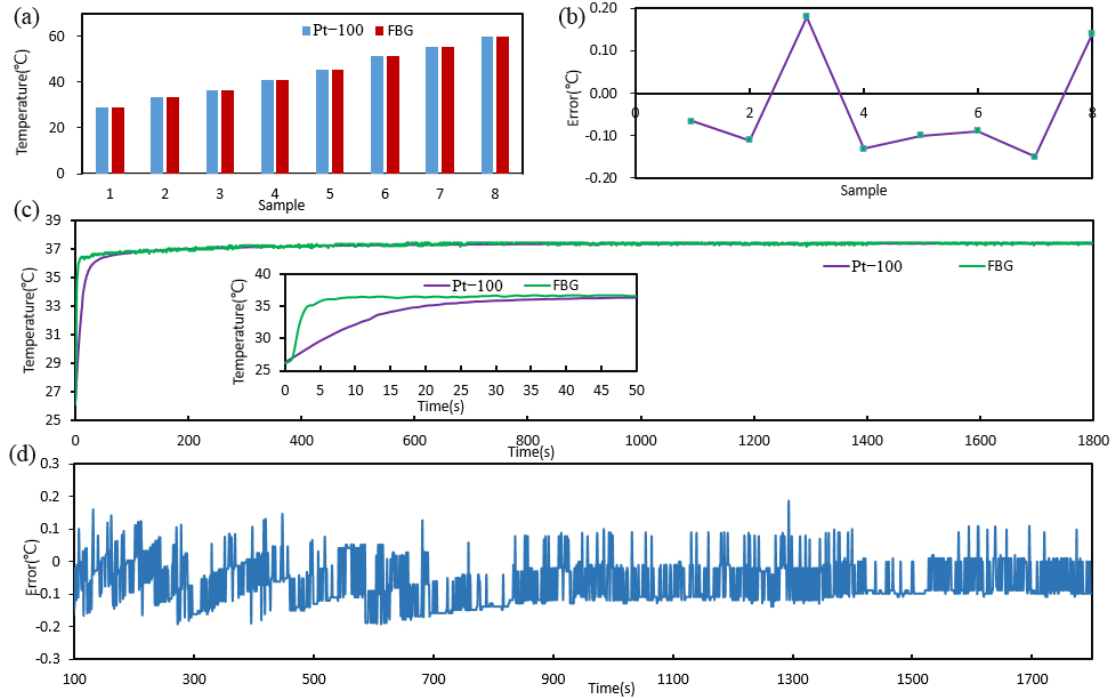
Figure 5. Temperature calibration verification and its error of the FBG sensor. ( a ) The static temper- ature measurement by the FBG sensor and the Pt-100 sensor, and ( b ) the errors of the FBG sensor relative to the Pt-100 sensor. ( c ) The body temperature monitoring of about 30 min by the FBG sensor and Pt-100 sensor, and ( d ) the errors of the FBG sensor relative to the Pt-100 sensor.